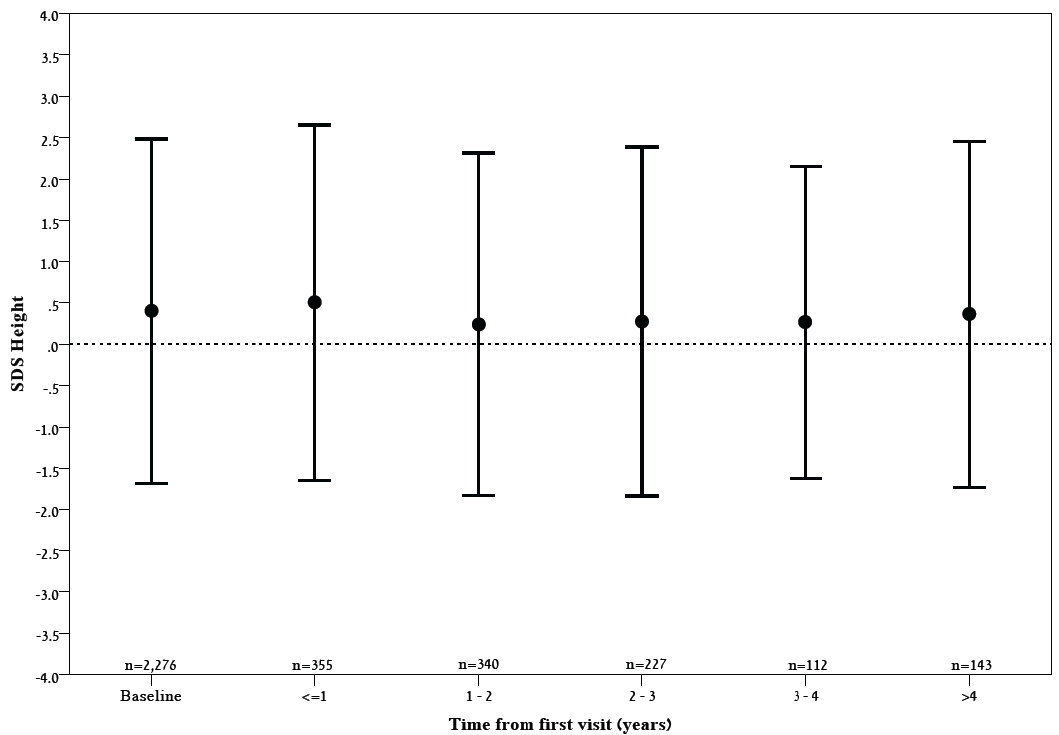
Figure 2. Height SDS changes, presented as the mean +95% confidence interval, during follow-up measurements since the first clinic visit ( n = 688). Table 2. Changes in height SDS over time calculated from generalized estimating equations, adjusted for age at first visit and sex, in athletes with repeated measurements from the most common sport types.